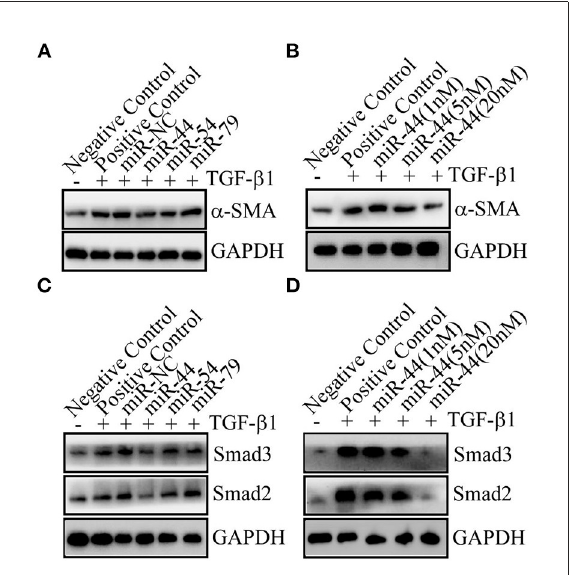
FIGURE8 The miR-44 in TEVs was identified to inhibit liver fibrosis. (A) The miR-44 can inhibit liver fibrosis. 20nM of miRNA mimic or miRNA (miR) negative control (NC) were transfected. The protein expression levels of α -SMA were detected. (B) The miR-44 dose-dependently decreased α -SMA protein expression. Different amounts of miRNA negative control were co-transfected with miR-44 to ensure the total transfected RNAs of 20nM. (C) The miR-44 had an effect on Smads signal. 20nM of miRNA mimic or miR-NC were transfected. The protein expression levels of Smad2 and Smad3 were detected. (D) The miR-44 dose-dependently decreased Smad2 and Smad3 protein expression. Different amounts of miRNA negative control were co-transfected with miR-44 to ensure the total transfected RNAs of